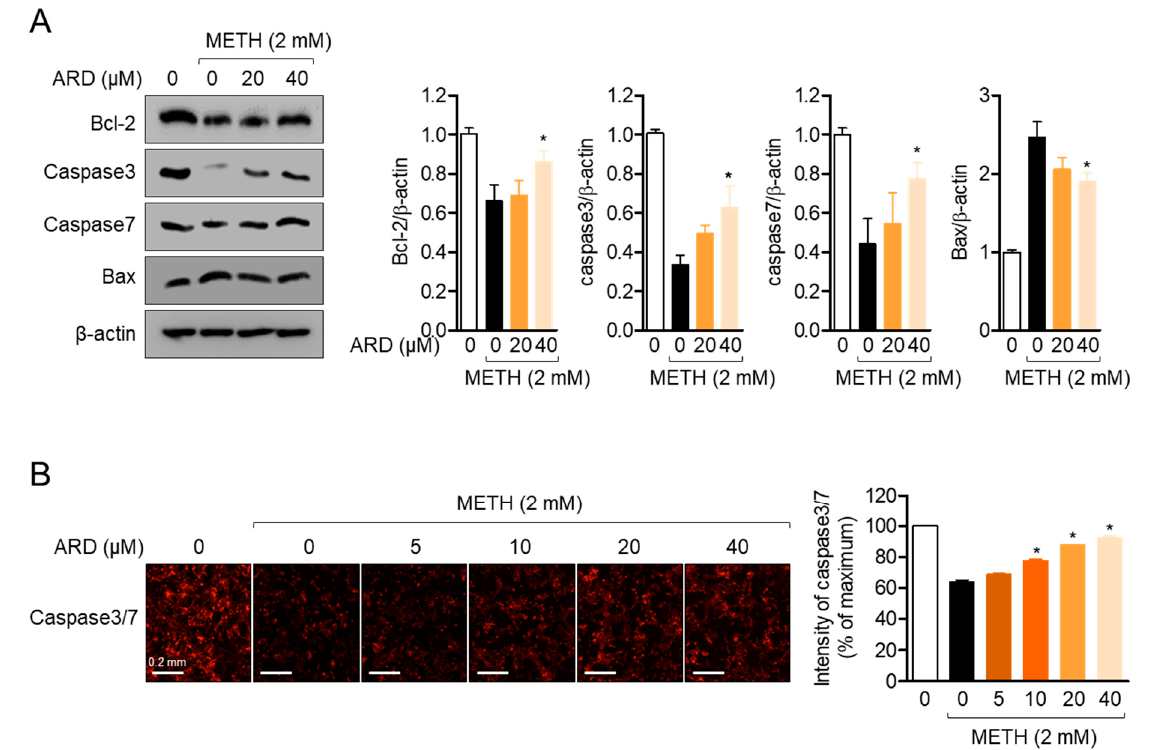
Figure 8. ( A ) SH-SY5y cells (1 × 10 5 /well, 6-well plate) were pre-treated with the indicated concentration (0 to 40 μ M) of aromadendrin for 1 h and exposed to 2 mM METH for 24 h. After harvested, cells were lysed for Western blotting analysis. The indicated proteins were detected and normalized with the level of β -actin. ( B ) Stained SH-SY5y cells (5 × 10 3 /well, 96-well plate) with 1 × Caspase3/7 staining reagent were pre-treated with the indicated concentration (0 to 40 µ M) of aromadendrin for 1 h and exposed to 2 mM METH for 24 h. The expression of Caspase3/7 was detected, and the intensity of Caspase3/7 was measured using the IncuCyte ® imaging system. White bar indicates 0.2 mm. The mean value of three experiments ± SEM is presented. * p < 0.05 between METH-treated cells.